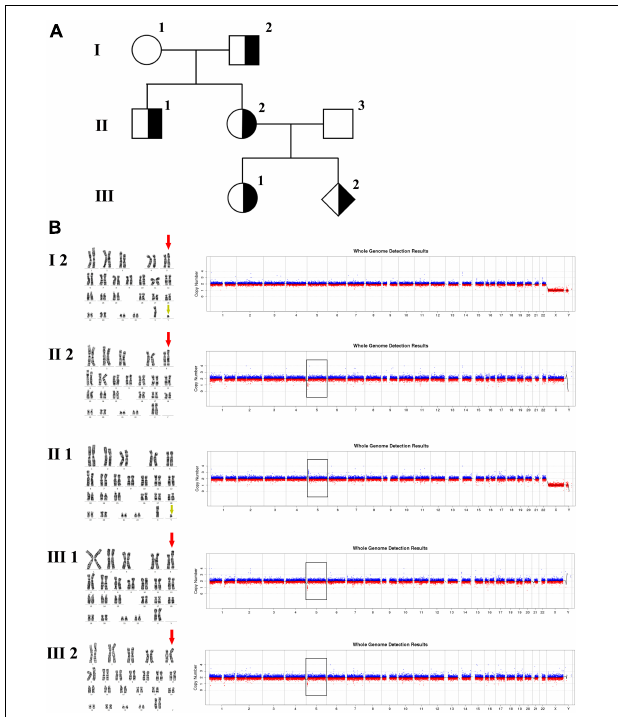
FIGURE 2 | Karyotyping and CNV-seq results of family 2. (A) The pedigree of the family 2. (B) Karyotyping and CNV-seq results. The red arrow indicates the derived chromosome 5 in karyotyping results, and the yellow arrow indicates the derived chromosome Y. The box indicates the deletion or duplication of 5p in CNV-seq